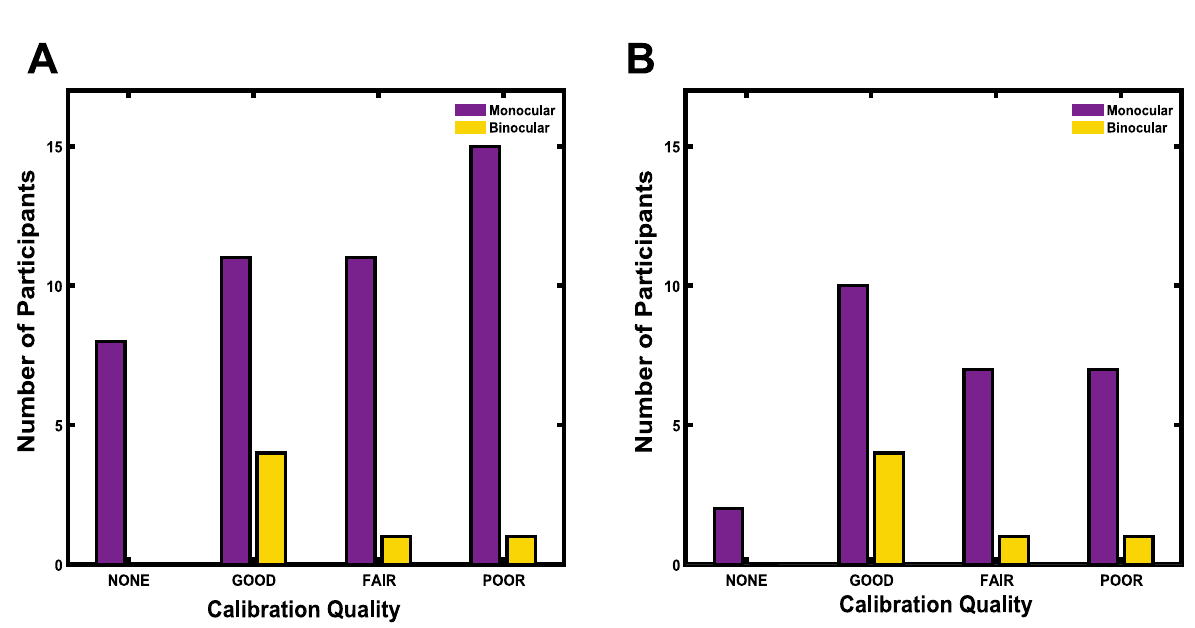
Fig 6. Validation quality and monocular and binocular success rates. Data is shown for participants for whom (A) eye-tracking was attempted (n = 51) and (B) whose data met quality thresholds for analysis of oculomotor metrics (n = 32). Although monocular data was used for analyses, binocular recording was attempted for all participants to maximize the probability of collecting high quality data from at least one eye. If calibration was repeated, only the final attempt is reported here. Infants for whom calibration was aborted or skipped after multiple unsuccessful attempts are represented by the “None”